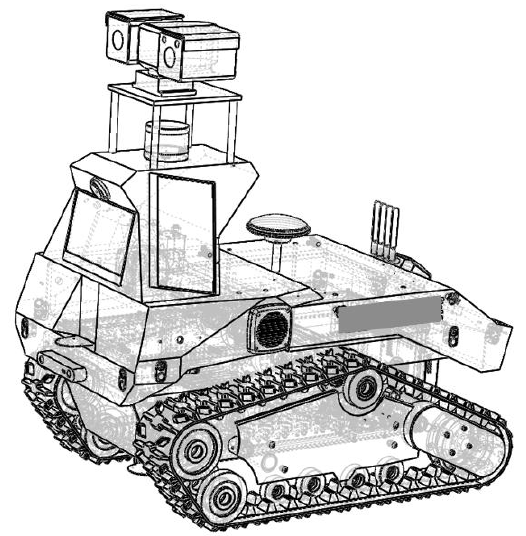
Figure 11. Logistics inspection